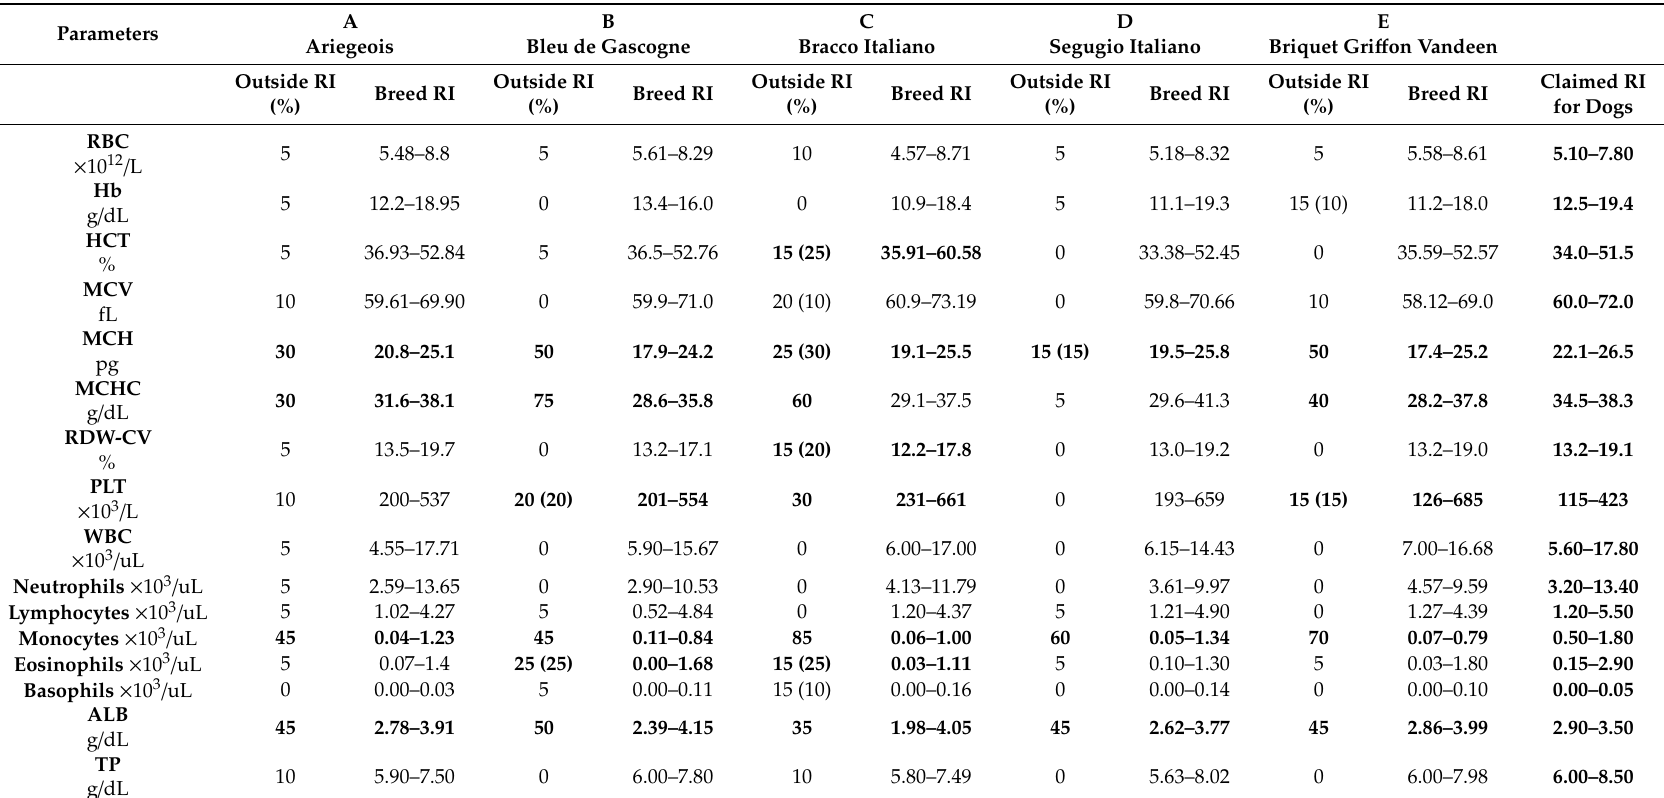
Table 1. Reported Reference Intervals (RIs) currently used in our laboratory (claimed RIs) and the new breed-specific RIs for each hunting dog breed (A: Ariegois; B: Bleu de gascogne; C: Bracco italiano; D: Segugio italiano; E: Briquet Gri ff on Vandeen). Statistical analysis was obtained after the removal of data that behave as outliers interpretable as aberrant observations. The first 20 items for each analyte were randomly selected and compared with the claimed laboratory RIs. The standard laboratory RIs were validated if 10% or less (0–2) of data fell outside the RI; on the other hand, they were rejected if > 25% of data (5 or more) fell outside the RI. If 10–25% of data lay outside the laboratory RIs, the next 20 items on the list were selected and compared with the RIs as described above, using the threshold of 10% (% values in brackets) of data outside the RIs ( n = 2) to validate or reject the RIs When the published RI was rejected, a new RI, reported in bold, was established following the ASVCP [21] and NCCLS [37]